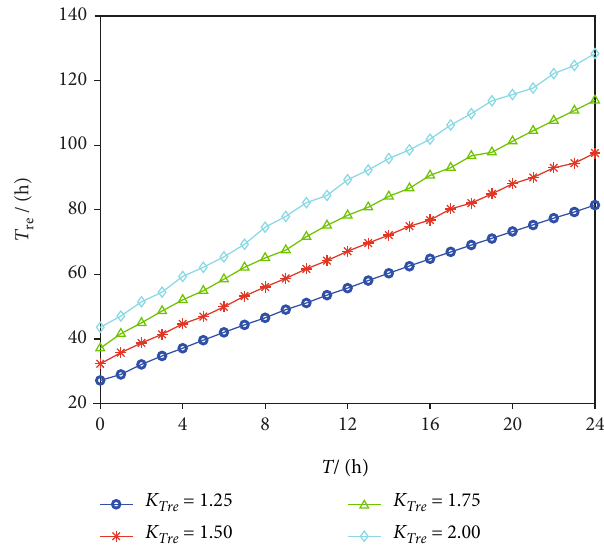
Figure 9: Abort return time versus the abort time of the two- impulse abort orbit under di ff erent maximum abort return time